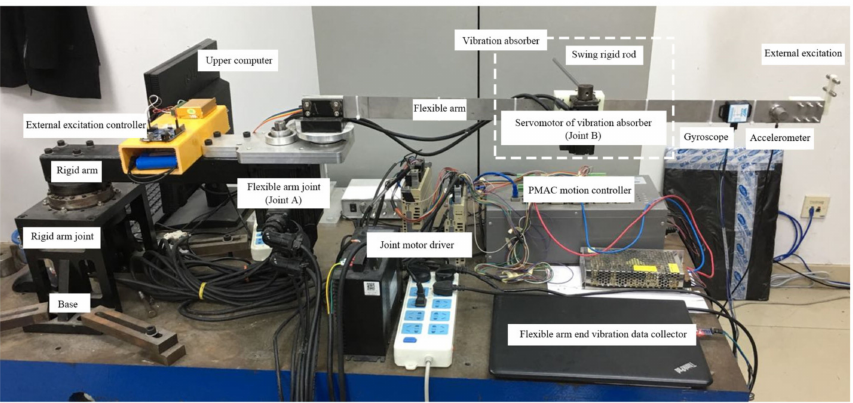
Figure 15. Experimental setup for primary resonance